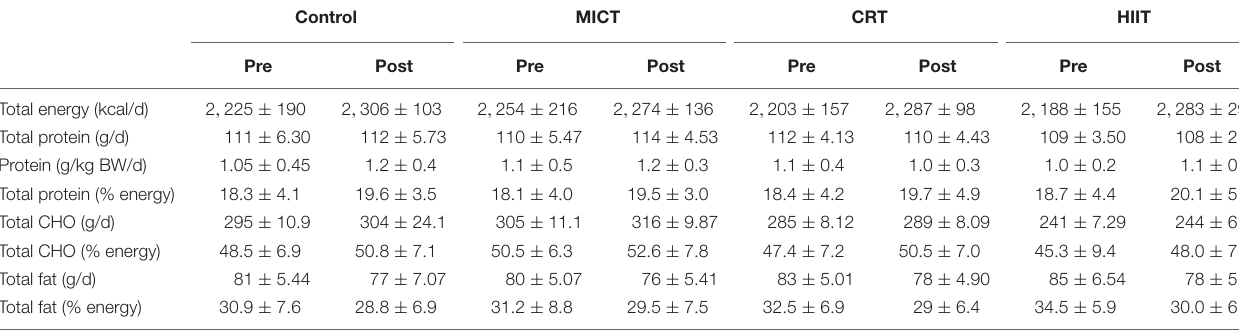
TABLE 2 | Mean (sd, ± ) values of nutritional intake by group. Control MICT CRT